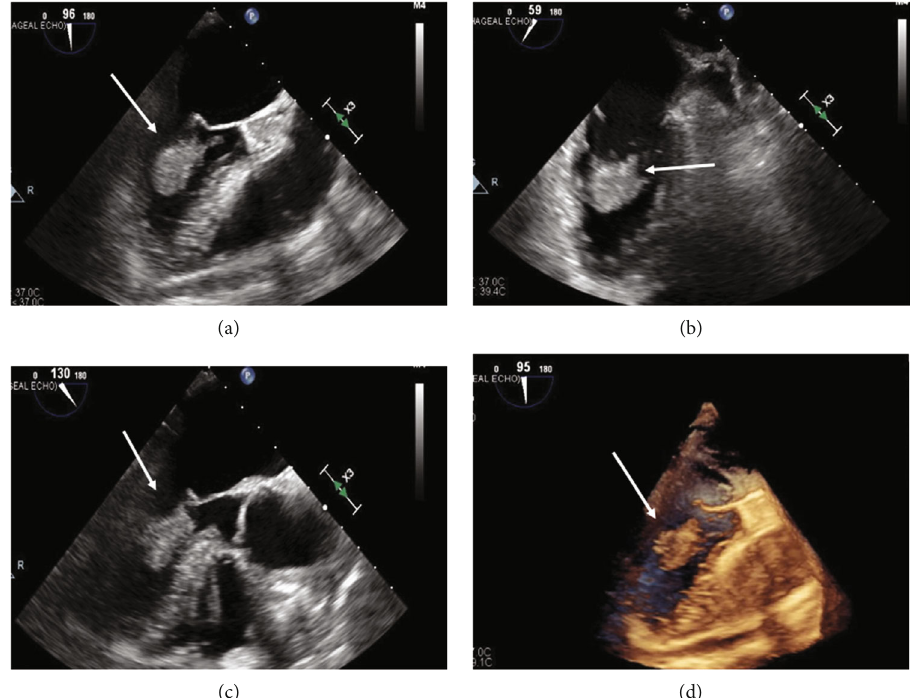
Figure 2: Transesophageal echocardiogram. Panels (a), (b), (c), and (d) show a large echogenic mass attached to the mitral valve apparatus and interventricular septum at di ff erent orthogonal